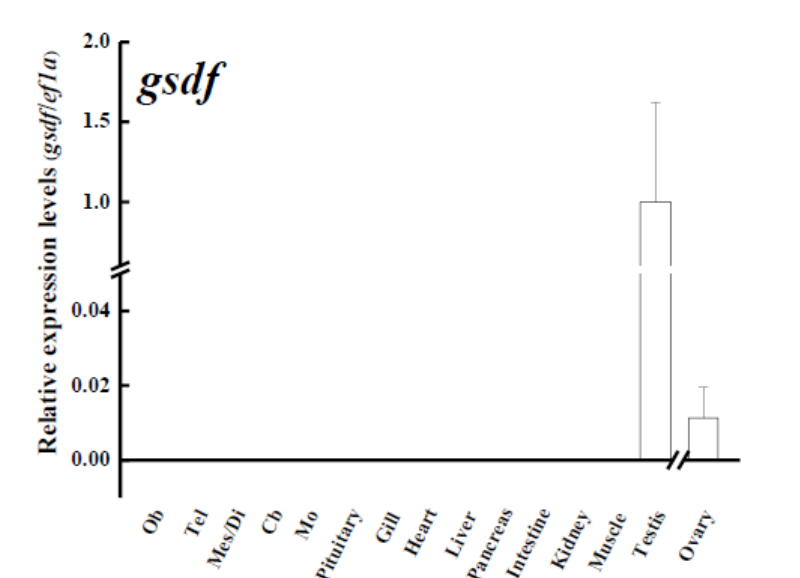
Figure 4. Transcript levels of ( A ) anti-Müllerian hormone ( amh ); ( B ) its receptor, amhr2 , ( C ) gonadal soma-derived factor ( gsdf ) in various tissues of male Japanese eel and ovary of female Japanese eels ( n = 3). Transcripts were measured by real-time polymerase chain reaction (qPCR). ef1a was used as an internal control gene. Data were expressed as means ± standard error of the mean (SEM). Ob: olfactory bulbs, Tel: telencephalon, Mes/Di: mes-/diencephalon, Cb: corpus cerebellum,